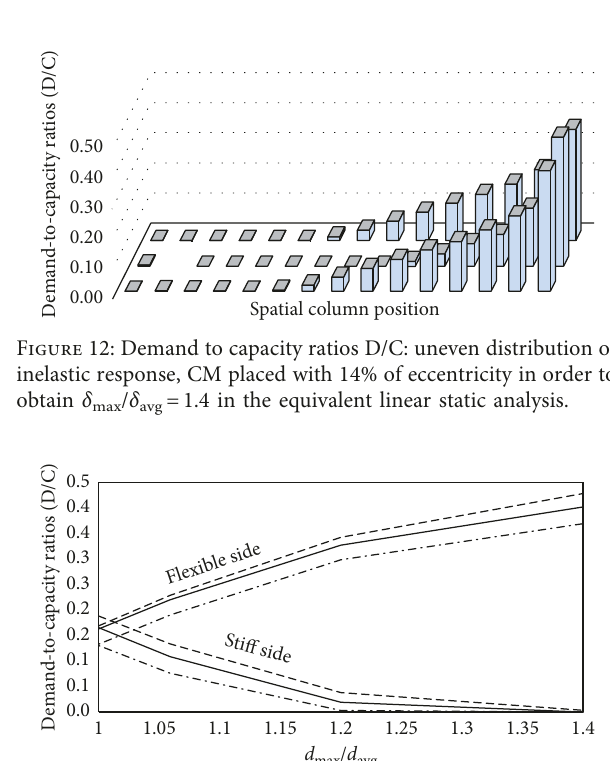
Figure 11: Demand to capacity ratios D/C: uneven distribution of inelastic response, CM placed with 6% of eccentricity in order to obtain δ max / δ avg 1.2 in the equivalent linear static analysis. (cid:31)